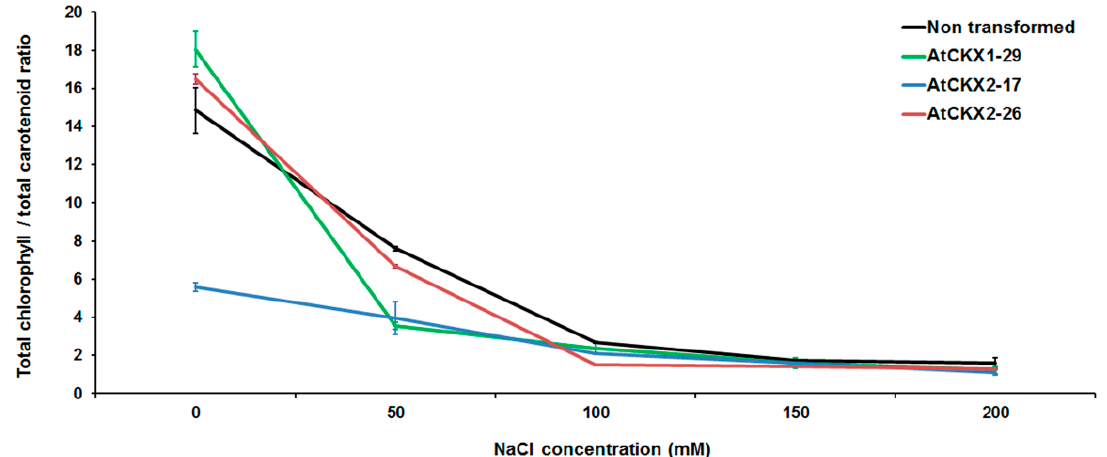
Figure 5. The total Chl and total carotenoid ratio in the shoots of non-transformed and transgenic centaury lines ( AtCKX1 -29, AtCKX2 -17, and AtCKX2 -26) after 8 weeks of growth in ½MS medium supplemented with 0-, 50-, 100-, 150-, and 200-mM NaCl. The data represent the mean ± standard error. Means marked with a different letter significantly different from the control, according to the LSD test ( p ≤ 0.05), are presented in Supplementary Materials.